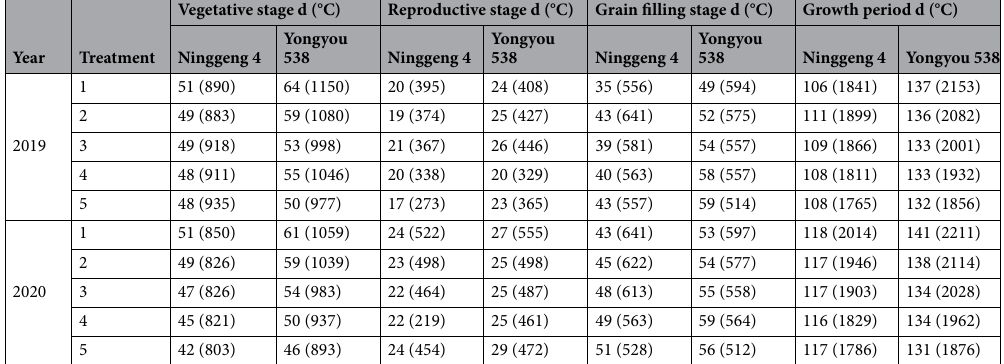
Table 2. Difference in growth period (effective accumulated temperature) of different treatments from 2019 to 2020.